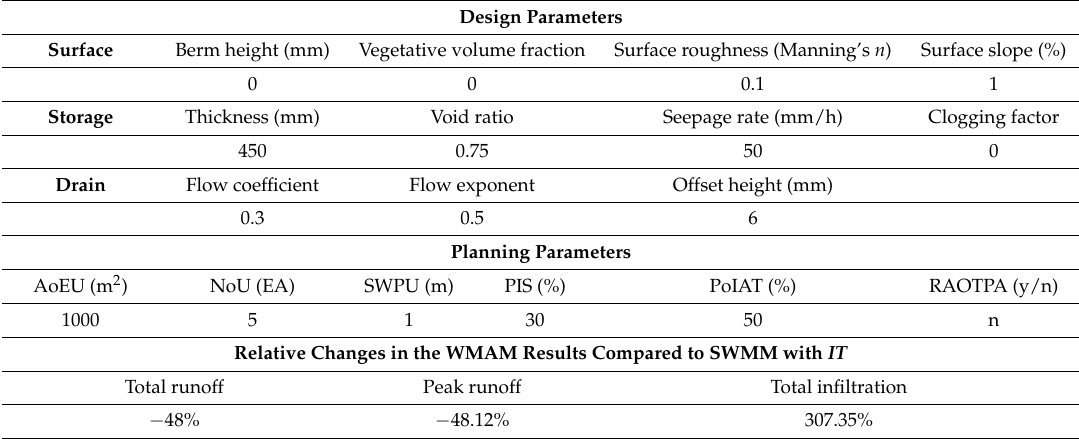
Table 7. Results of the derived best LID design and planning scenario using the